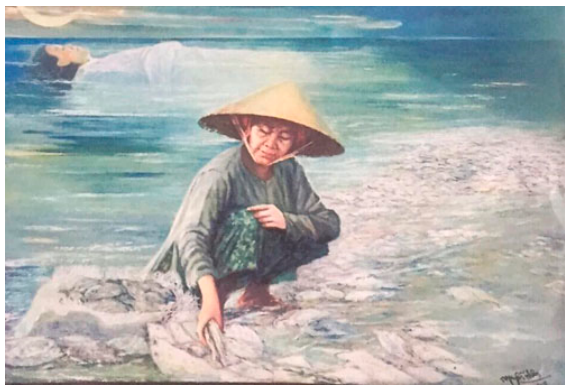
Figure A29. Bien chet —Nguyen Nhan painted in 2017. The image was sourced from VnExpress (Thanh 2017).